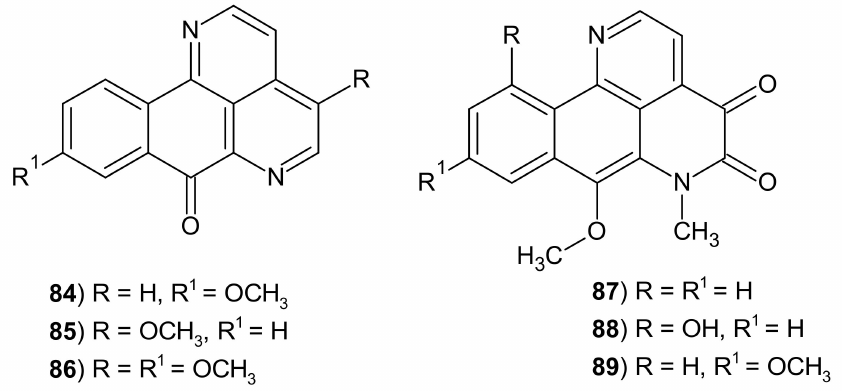
Figure 26. Eupomatidines 1–3 84 – 86 and imbilines 1–3 87 – 89 . Kitahara et al. [111] synthesized eupomatidines 1–3 84 – 86 and evaluated their